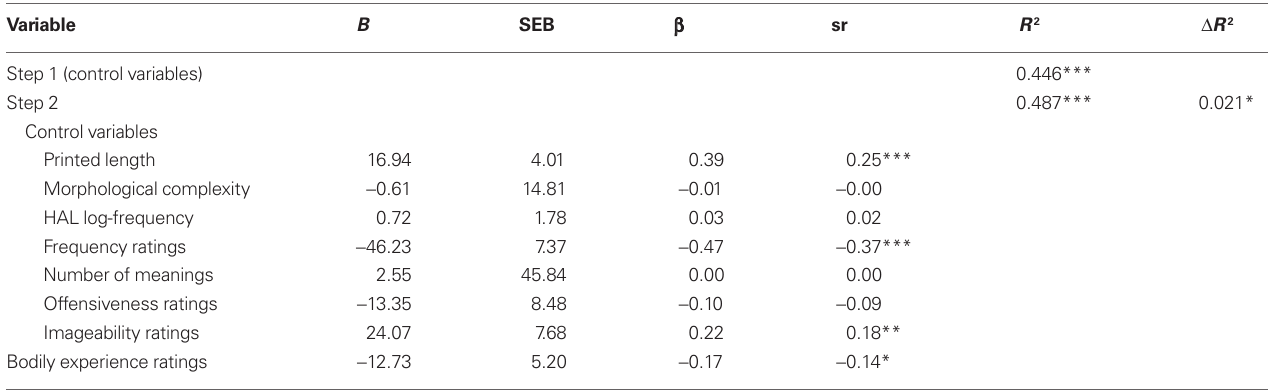
Table 4 | Results of hierarchical multiple regression analysis for insult detection task response latency data for Experiment 4. Variable